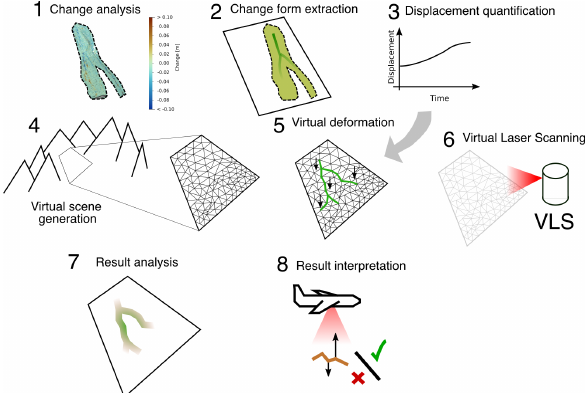
Figure 2. Overview of the processing and analysis steps presented in this